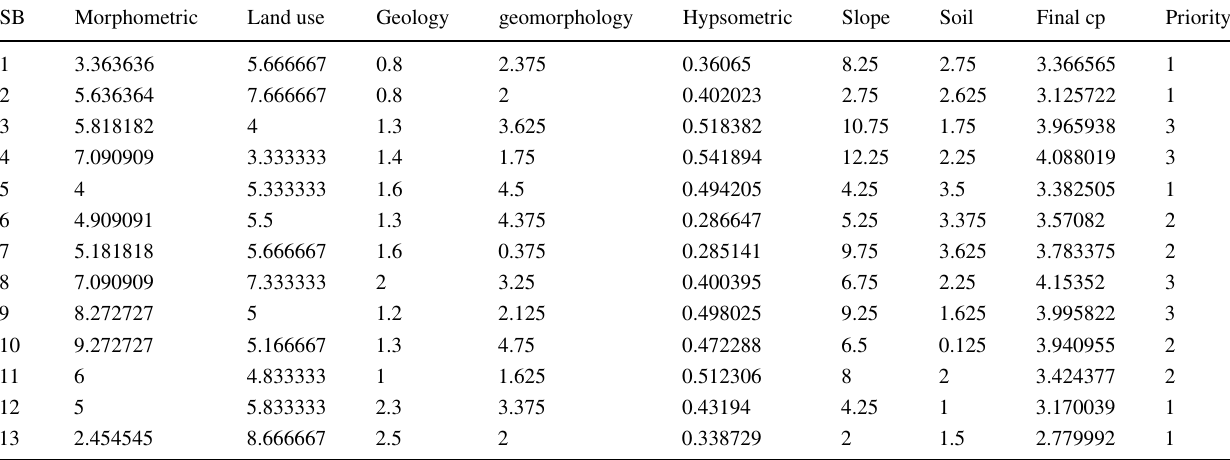
Table 11 Sub-basin-wise final priority of six themes in the entire catchment area SB